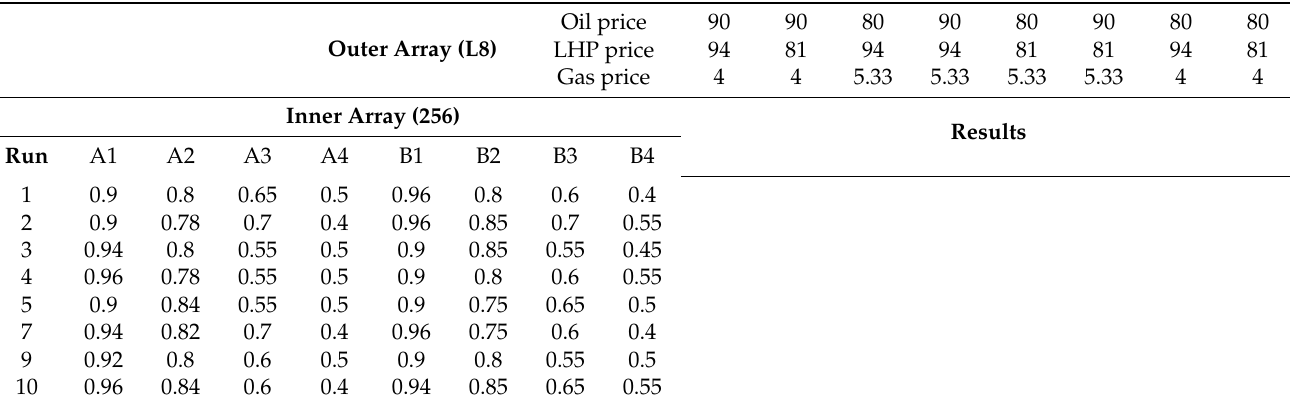
Table 5. Control and noise levels design (the first 10